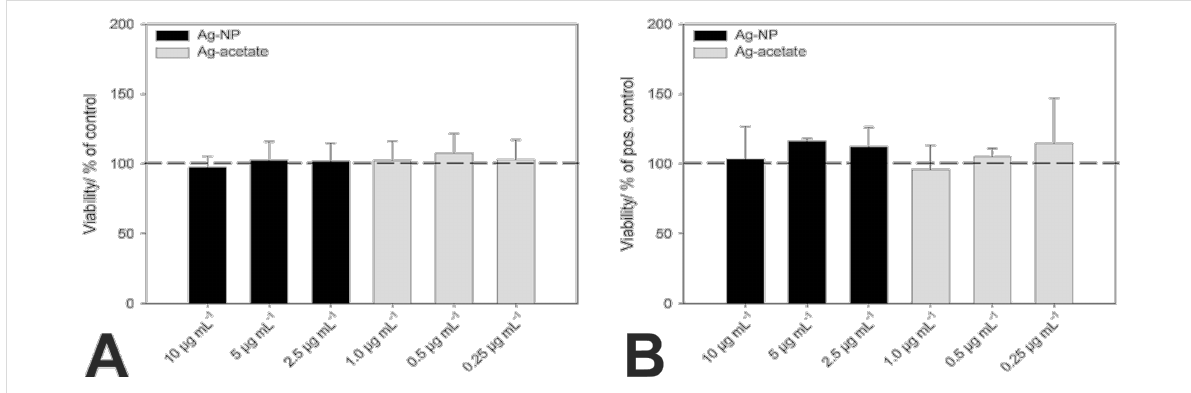
Figure 2: Influence of different Ag-NP/Ag + ion concentrations on the viability of undifferentiated hMSCs (A) and adipogenic-differentiated hMSCs (B). After 14 d of incubation, viable cells were stained with calcein-AM (green fluorescence) and quantified by using digital image processing (phase analysis). The data are expressed as the mean ± SD ( n = 3 independent experiments) given as the percentage of viable cells cultured in the pres- ence of RPMI/FCS (A) or in the presence of adipogenic-differentiation medium (B).